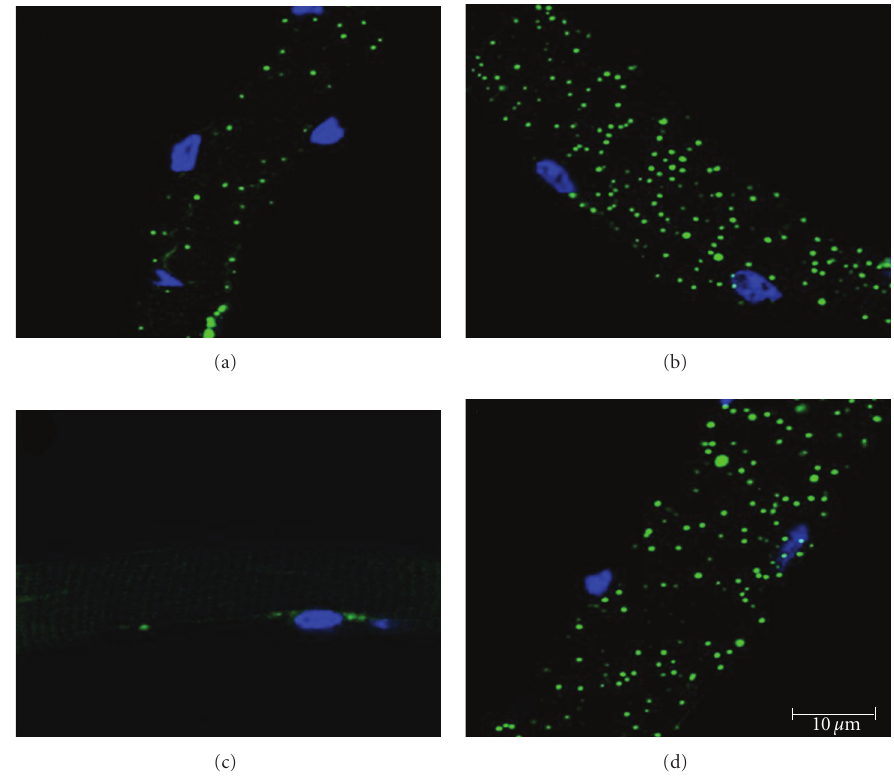
Figure 5: Exposure of single fibers to a palmitate-oleate mixture substantially increases the size and frequency of LDs within cultured mouse single muscle fibers. (a, c) Single muscle fibers isolated from the FDB were doubly stained with BODIPY (493/503-green) and DAPI (blue). The fibers were cultured overnight in standard media conditions. A heterogeneous mix of fibers presenting with LDs was found, in which some fibers presented with a visible number of LDs (a), while others presented with virtually no LDs (c). (b, d) Single muscle fibers isolated from the FDB were cultured overnight in standard media conditions supplemented with albumin-conjugated palmitate-oleate mixture (0.5mM:0.5mM ratio). A substantially higher number and larger LDs were found consistently across all fibers that were imaged. All images were taken at 63x, and a scale bar is provided for